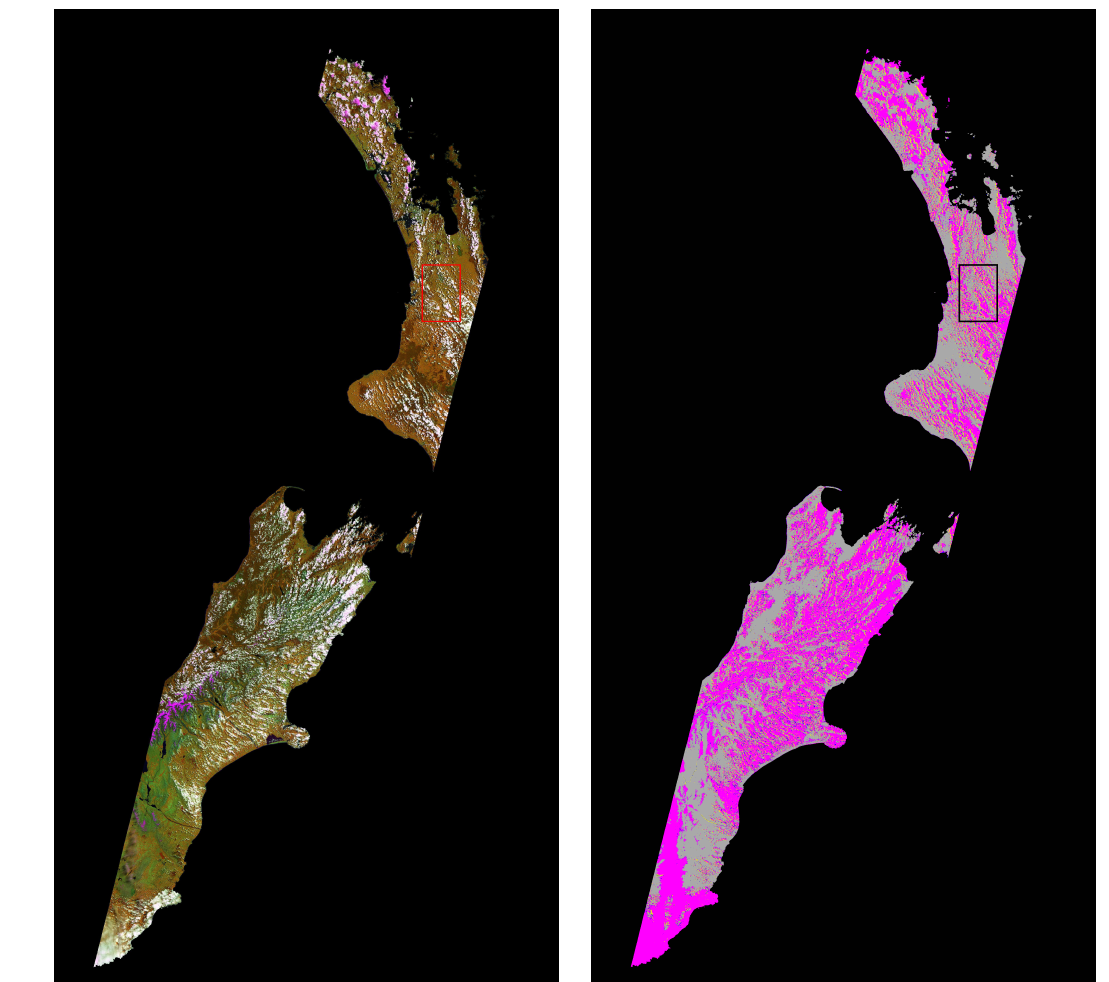
Figure 2. A typical Sentinel-2 overpass of New Zealand that contributed to the 2019/20 summer mosaic (R029, 20 December 2019). The left image is false-colour with bands B08 (near-infrared, NIR), B11 (short-wave infrared, SWIR), and B04 (Red) mapped to red, green, and blue. The right image is the classified cloud and cloud-shadow mask, with clouds in magenta and shadows in yellow (inset area shown more clearly in Figure